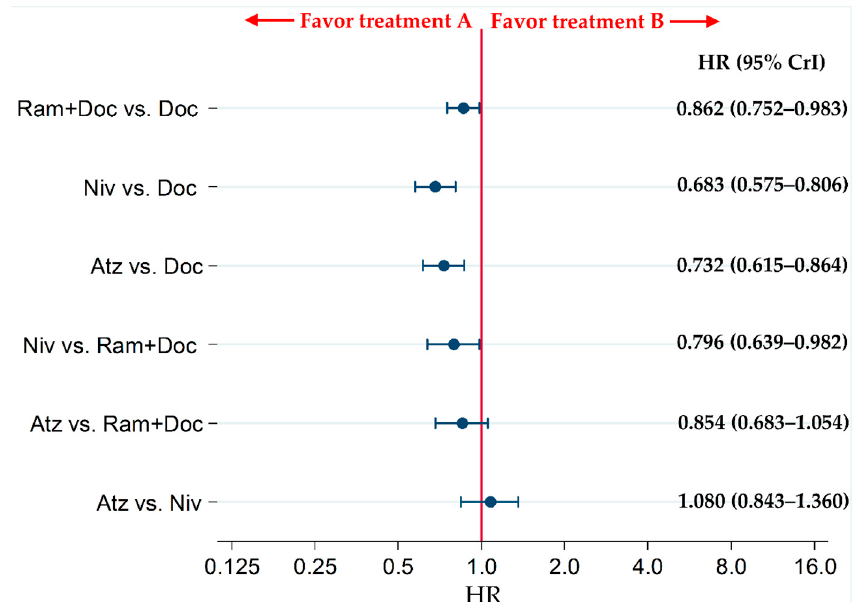
Figure 3. Comparative overall survival (OS) of patients with refractory or relapsed advanced non- small-cell lung cancer in the Ram+Doc, Doc, Niv and Atz groups. Patient inclusion criteria for all RCTs included in this analysis did not place any limitations on PD-L1 status. Comparisons are represented as treatment A versus treatment B. Data are presented as hazard ratios (HR) with 95% credible intervals (CrI). Ram+Doc (ramucirumab plus docetaxel); Doc (docetaxel); Niv (nivolumab); Atz (atezolizumab).